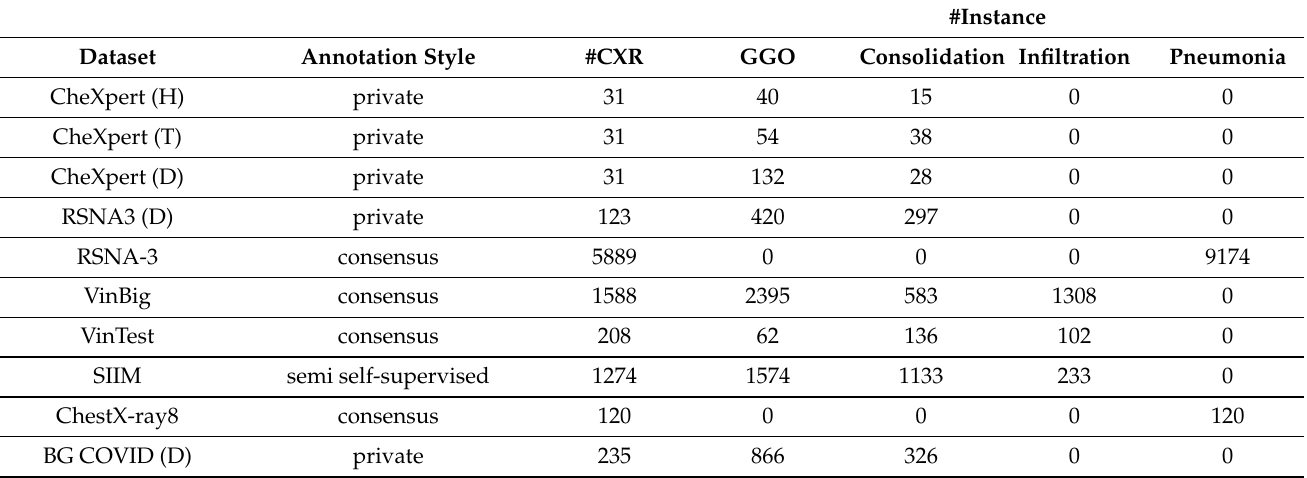
Table 1. COCO standardized dataset